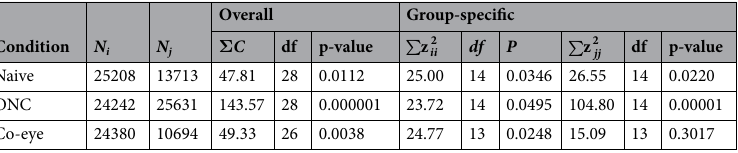
Table 2. Summary of Dixon’s χ 2 -test results across retinas from naive, ONC and contralateral eyes, each with N i ‘low activity’ microglia and N j ‘high activity’